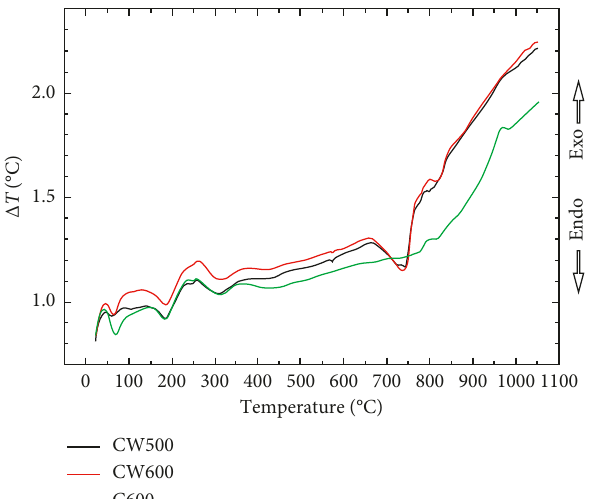
Figure 5: Comparison of DTA curves depicting the influence of woodchip ashes on the formation of coal ash eutectics, the first heating.